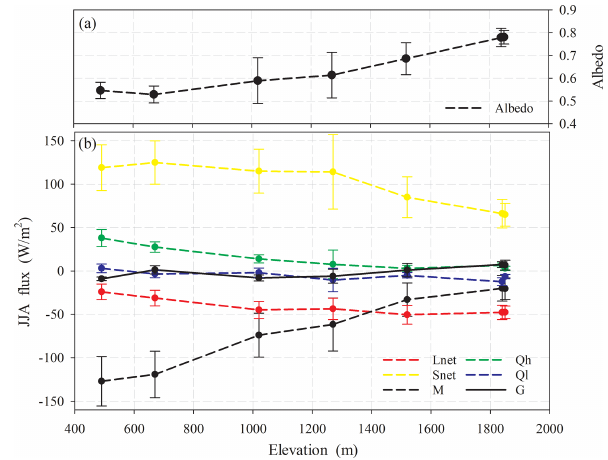
Figure 10. Mean June, July and August (JJA) SEB components and albedo versus elevation along the K-transect. Error bars indi- cate standard deviation in the multiyear annual